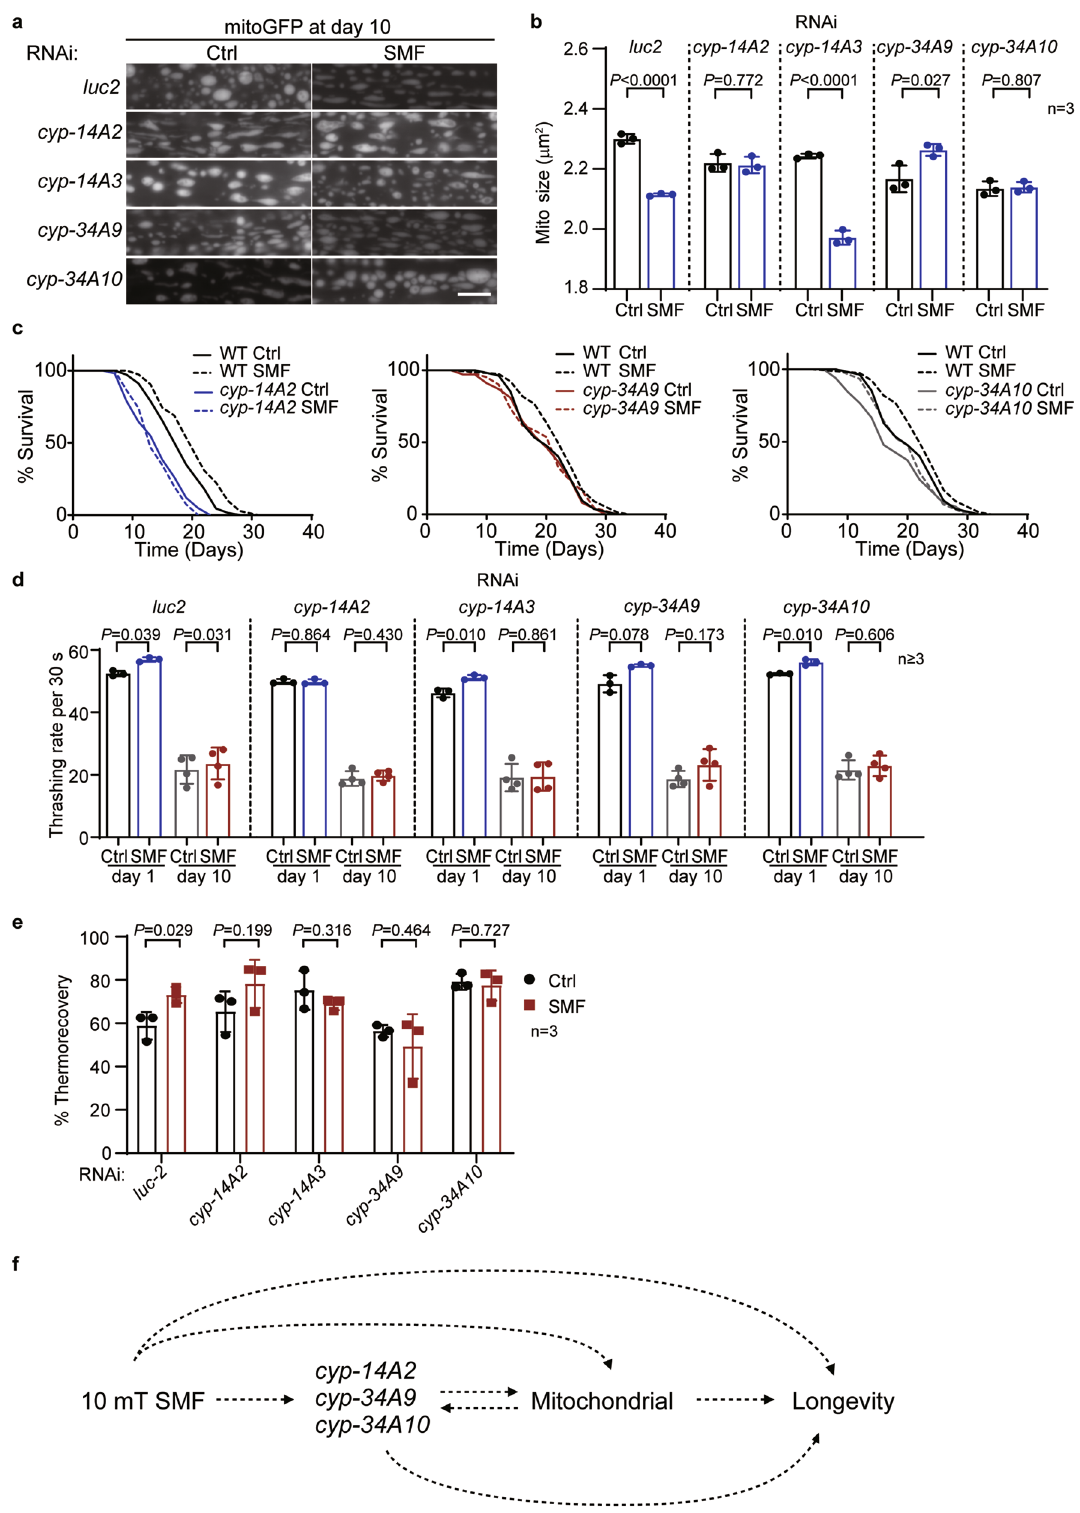
Figure 4. Cytochrome P450s are required for SMF-induced longevity. ( a ) Worms were treated with indicated RNAi and grown with or without SMF till day 10 of adulthood. Mitochondrial morphology in the body wall muscle was then examined. Scale bar: 5 μm. ( b ) RNAi against cyp-14A2 , cyp-34A9 , or cyp-34A10 blocks the effect of SMF on mitochondrial size at day 10 of adulthood. Unpaired t -test. ( c ) The survival curves of worms under indicated treatments. ( d ) The thrashing rates of worms at day 1 and day 10 of adulthood under indicated treatments. Paired t -test. ( e ) RNAi against the indicated CYP genes suppresses the improved thermorecovery by SMF treatment at day 1 of adulthood. Note that the worms under RNAi were fed with E. coli HT115, whereas the worms in Fig. 1b with E. coli OP50. Although different food caused different response to heat shock, SMF consistently increased thermorecovery. ( f ) A schematic summary of the SMF-induced longevity in C. elegans